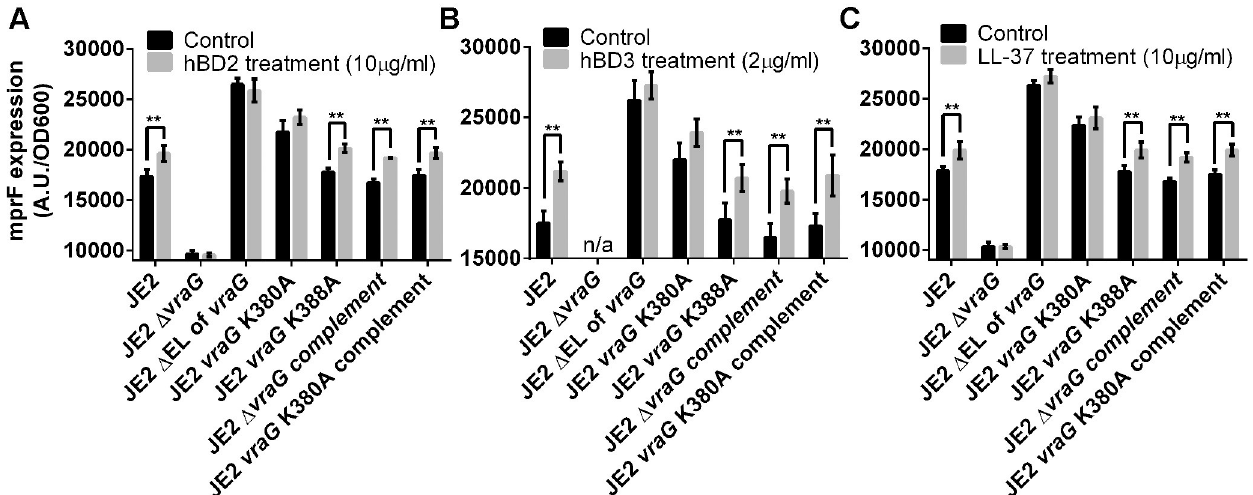
Fig 7. The Δ EL vraG mutant is insensitive to HDPs for mprF expression. Cells grown to OD 600 of 0.7–0.8 were divided into two treatment groups each, including treatment of h-BD2 (A) , h-BD3 (B) or LL-37 (C) and water as a control. After 30 min, we monitored OD 600 (cell growth) and fluorescent intensities of the cells. The results were obtained from three biological replicates. � indicates p < 0.01, using the Student-t test. In the case of Δ vraG with h- BD3, cell growth was impaired so that the results were excluded.